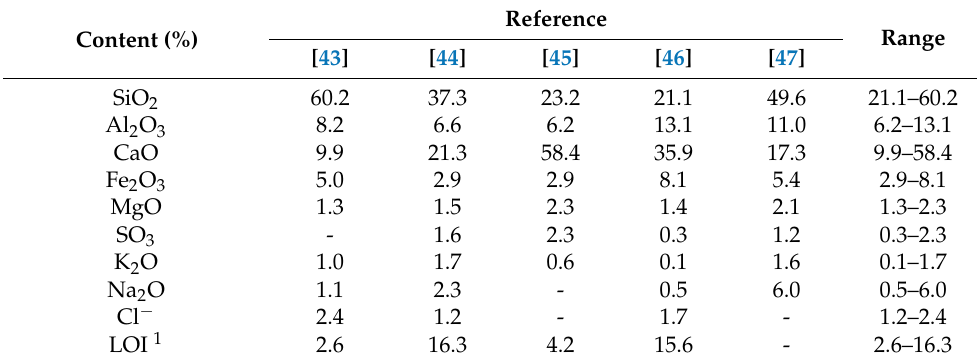
Table 2. Chemical composition of MSWI-BA from selected literature